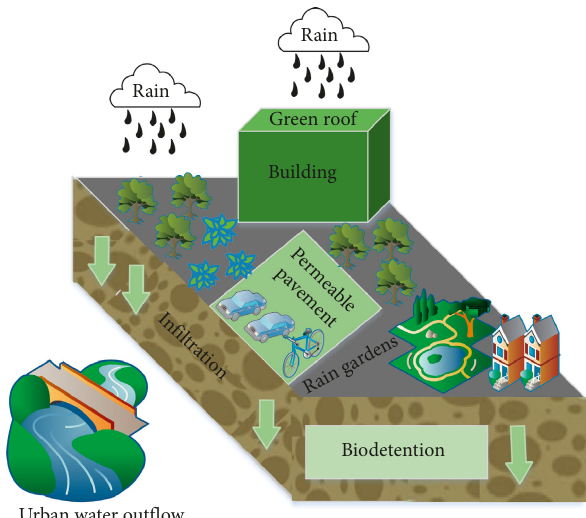
Figure 1: Schematic diagram of the Sponge city